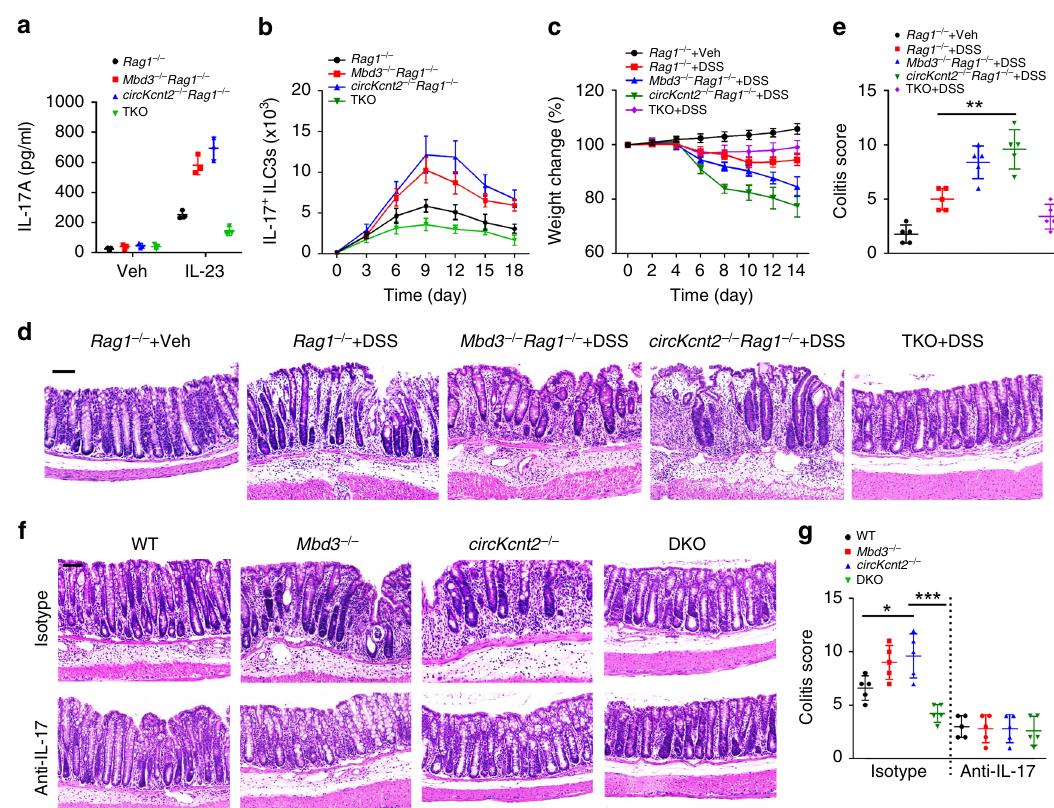
Fig. 7 Mbd3 deletion causes severe innate colitis while Batf deletion promotes colitis resolution. a ILC3s isolated from indicated mice were used for ELISA assay to analyze IL-17 production. TKO, circKcnt2 − / − Batf − / − Rag1 − / − mice. n = 3 independent samples. b Cell numbers of IL-17 + ILC3s were analyzed in indicated mice after DSS treatment. n = 5 for each group. c Analysis of body weight changes of indicated mice after DSS treatment. n = 5 for each group. d H&E staining of colons from indicated mice treated with DSS. Scale bar, 100 μ m. e Colitis scores of indicated mice as in d (** P = 0.0011). f ILC3s (3 × 10 4 cells per mouse) isolated from Mbd3 − / − , circKcnt2 − / − , circKcnt2 − / − Batf − / − (DKO), or WT control mice were transplanted into Rag1 − / − Il2rg − / − mice. Two weeks later, mice were administrated with DSS and anti-IL-17 or isotype IgG. Colons were isolated and analyzed by H&E staining. Scale bar, 100 μ m. g Colitis scores of indicated mice as in f (* P = 0.0219; *** P = 0.0006). n = 5 independent samples. * P < 0.05 and ** P < 0.01. Data are shown as means ± SD. Data were analyzed by an unpaired Student ’ s t -test and representative of at least three independent experiments. Source data are provided as a Source Data fi